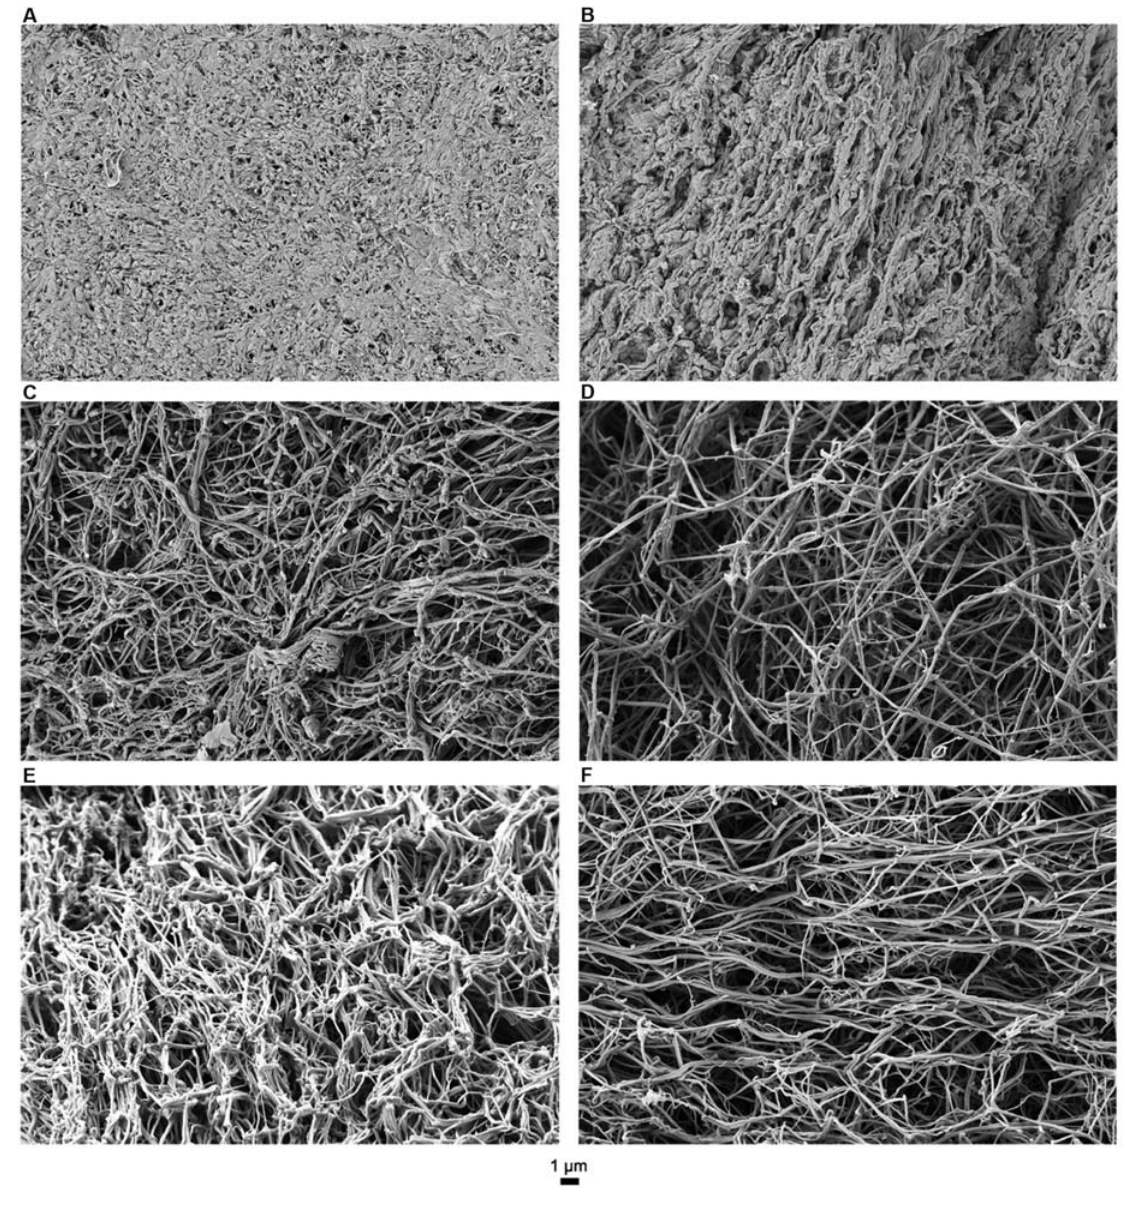
Fig. 4 Representative scanning electron microscopy images of fi brin clots. ( A ) rFVIIa (1.75µg/mL); ( B ) rFVIIa (5.25 µg/mL); ( C ): rFVIIa (1.75 µg/mL) þ SIA (200 nM); ( D ) rFVIIa (5.25 µg/mL) þ SIA (200 nM); ( E ) rFVIIa (1.75 µg/mL) þ SIA (600 nM); ( F ) rFVIIa (5.25 µg/mL) þ SIA (600 nM). rFVIIa: recombinant activated factor VII; SIA, sequence-identical